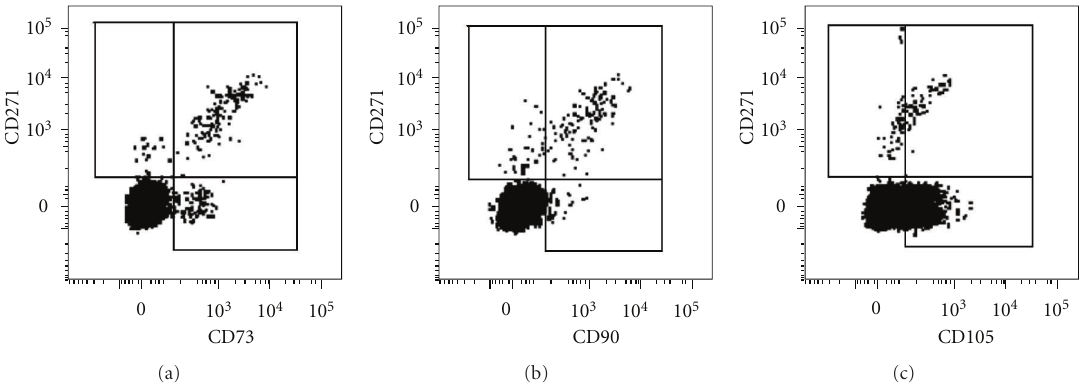
Figure 1: Coexpression of (a) CD271/CD73, (b) CD271/CD90, and (c) CD271/CD105 on CD45-/low cells in human bone marrow aspirates determined by flow cytometry. Mononuclear cells were isolated from bone marrow aspirates and stained with antibodies as previously described